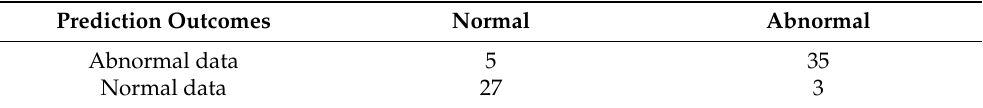
Table 3. Prediction result of acoustic signal to be